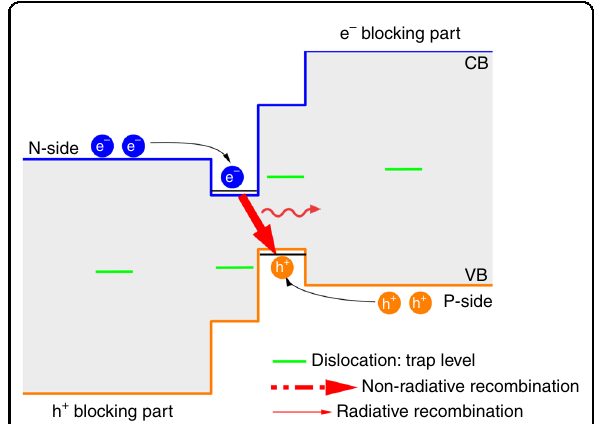
Fig. 13 Representation of the recombination channels in an ICL. Adapted from ref. 38 , used in accordance with the Creative Commons Attribution (CC BY)